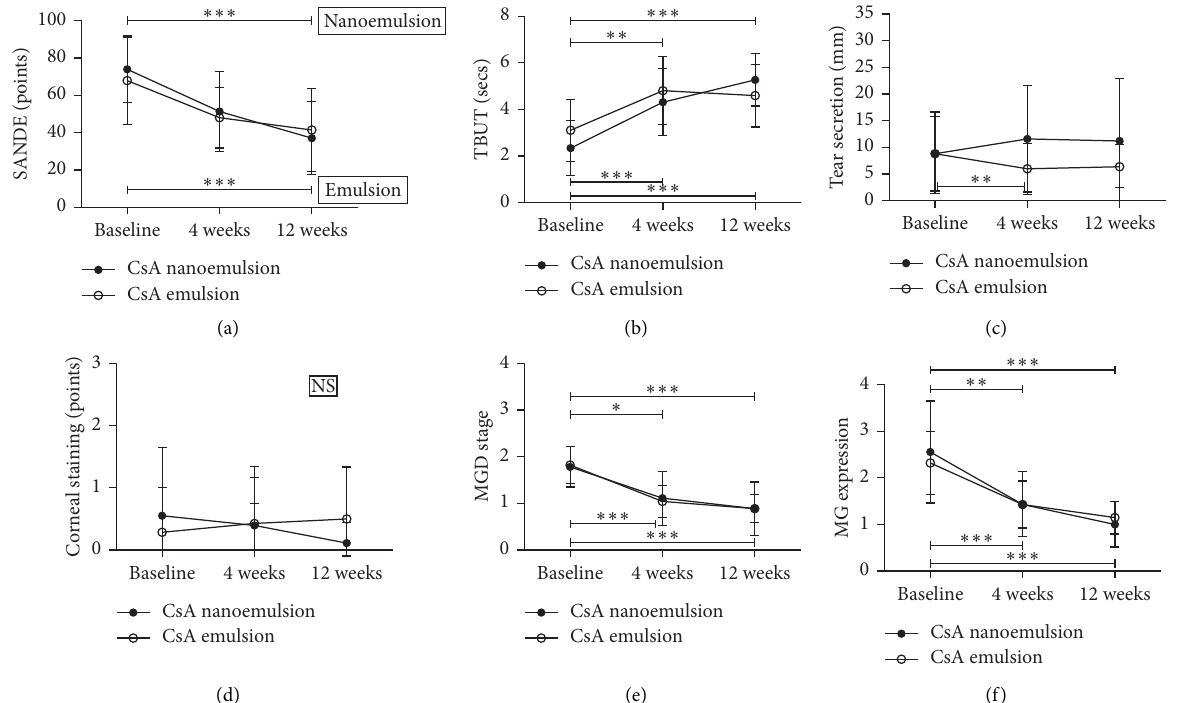
Figure 3: Changes in dry eye parameters at baseline and 4 and 12 weeks after treatment. CsA, cyclosporin; SANDE, symptom assessment in dry eye; TBUT, tear film breakup time; MGD, meibomian gland dysfunction; MG, meibomian